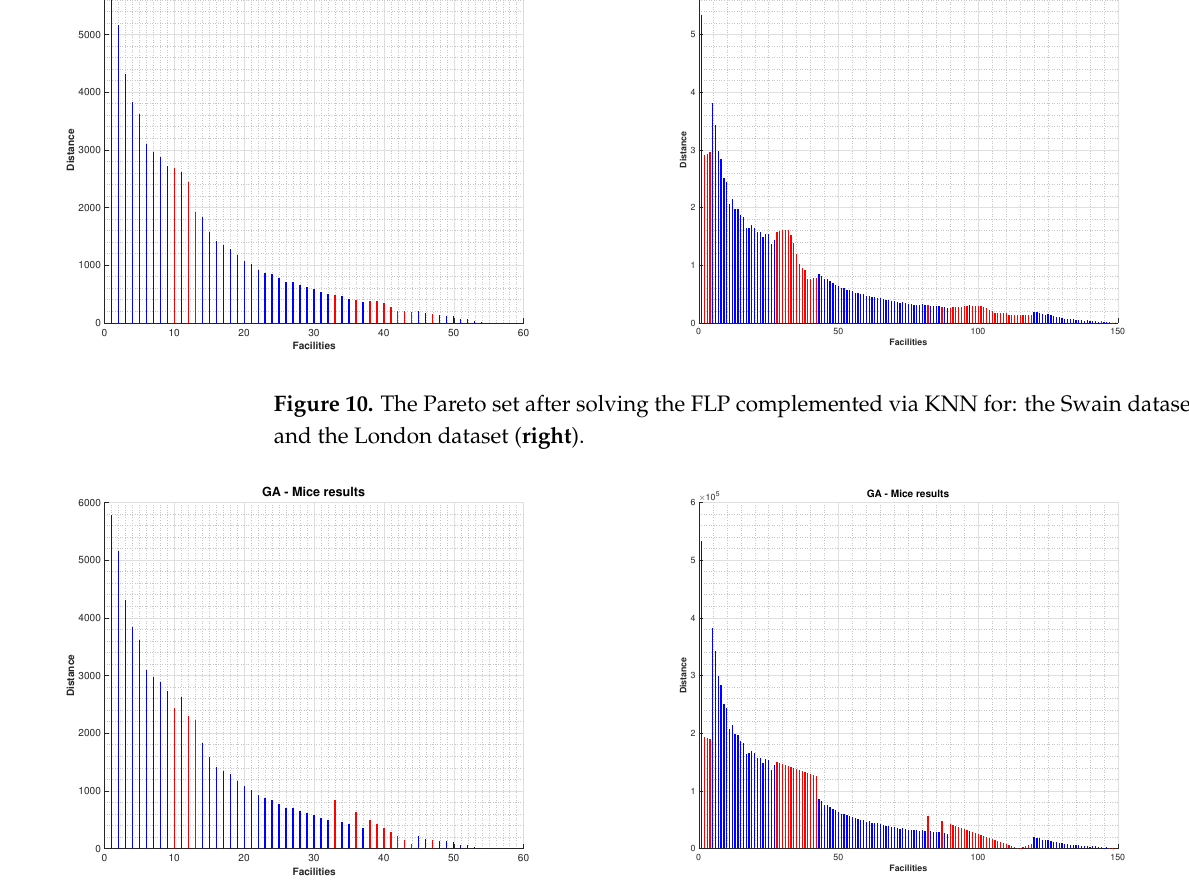
Figure 11. The Pareto set after solving the FLP complemented via MICE for: the Swain dataset ( left ), and the London dataset ( right